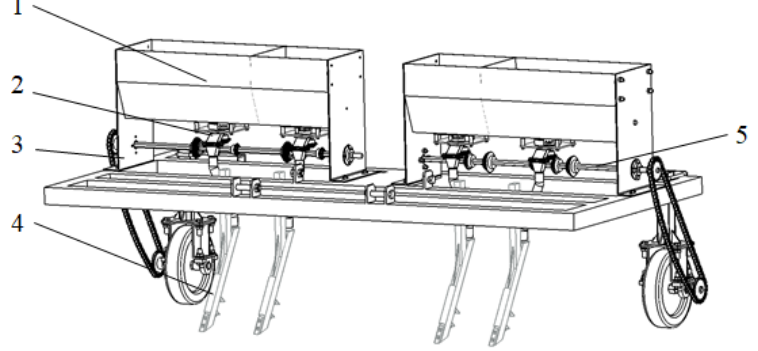
Figure 2. Structure diagram of fertilizer apparatus. 1. Fertilizer box; 2. Vertical variable cavity ferti- lizer apparatus; 3. Support plate; 4. Fertilizer boots; 5. Fertilizer discharging shaft.